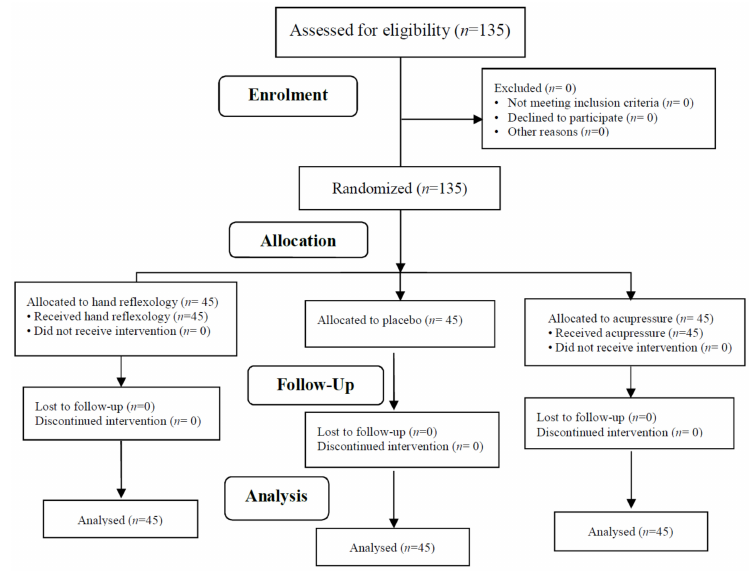
Figure 1. Process of the study according to the Consort flow diagram